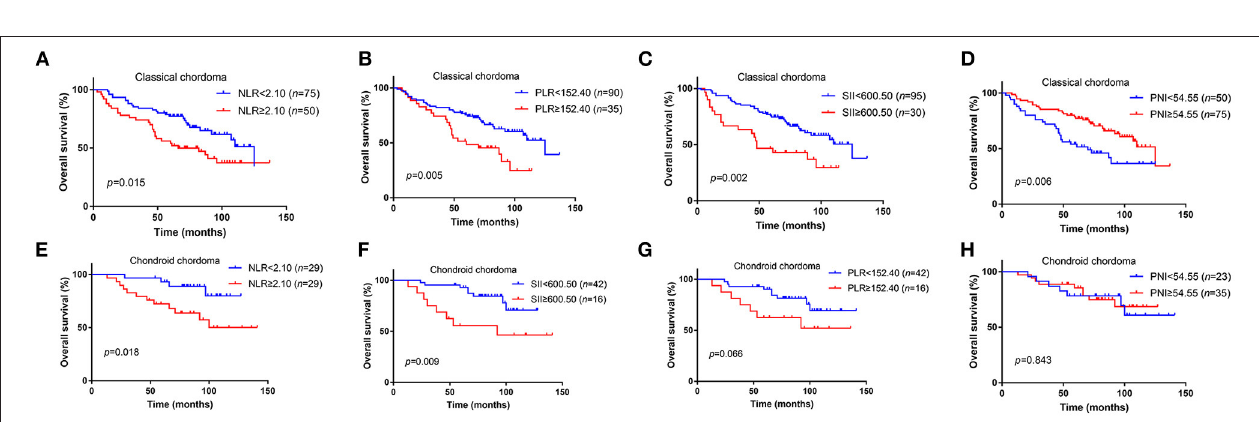
FIGURE 1 | Kaplan–Meier survival curves of NLR, PLR, SII, and PNI for OS in skull base chordoma patients. (A) Patients with high NLR had worse OS than those with low NLR ( p = 0.003). (B) Patients with high PLR had worse OS than those with low PLR ( p = 0.001). (C) Patients with high SII had worse OS than those with low SII ( p < 0.001). (D) Patients with low PNI had worse OS than those with high PNI ( p = 0.024). NLR, neutrophil lymphocyte ratio; PLR, platelet lymphocyte ratio; SII, systemic immune-inflammation index; PNI, prognostic nutritional index; OS, overall survival.